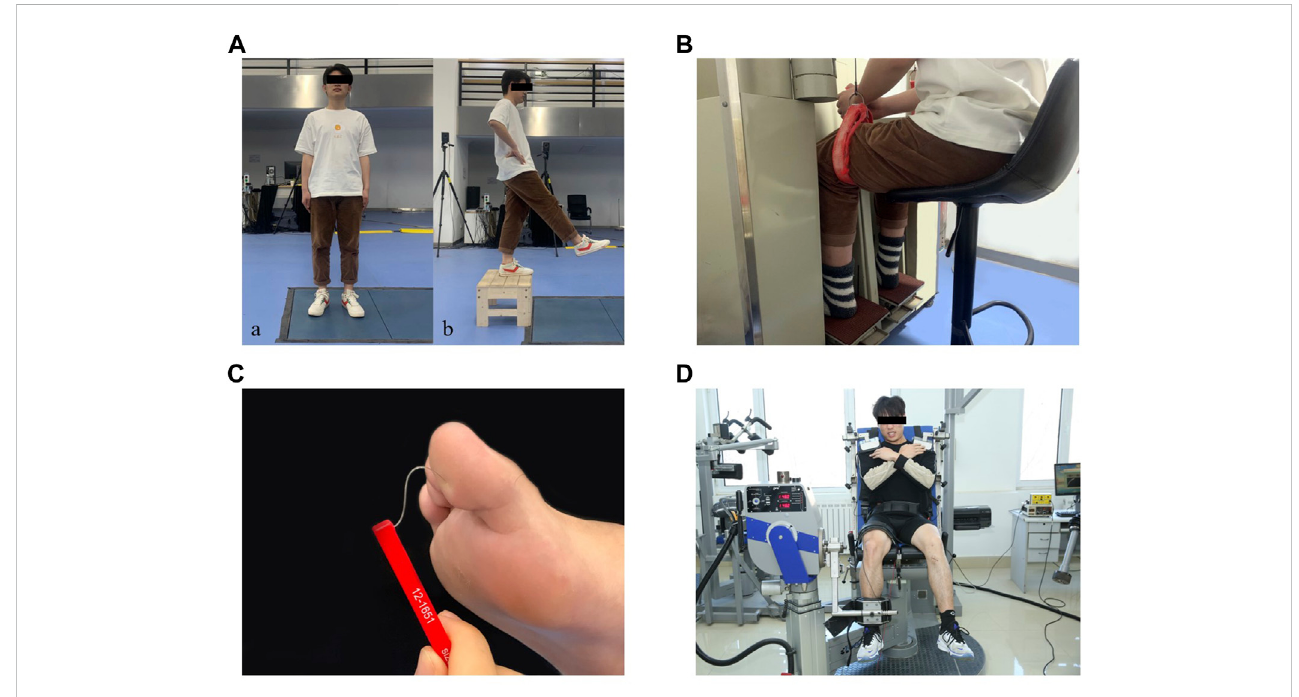
FIGURE 1 Test illustrations: (Aa) : Static postural stability test. (Ab) : Dynamic postural stability test. (B) : Joint kinesthesia test. (C) : Plantar tactile sensation test. (D) : Muscle strength